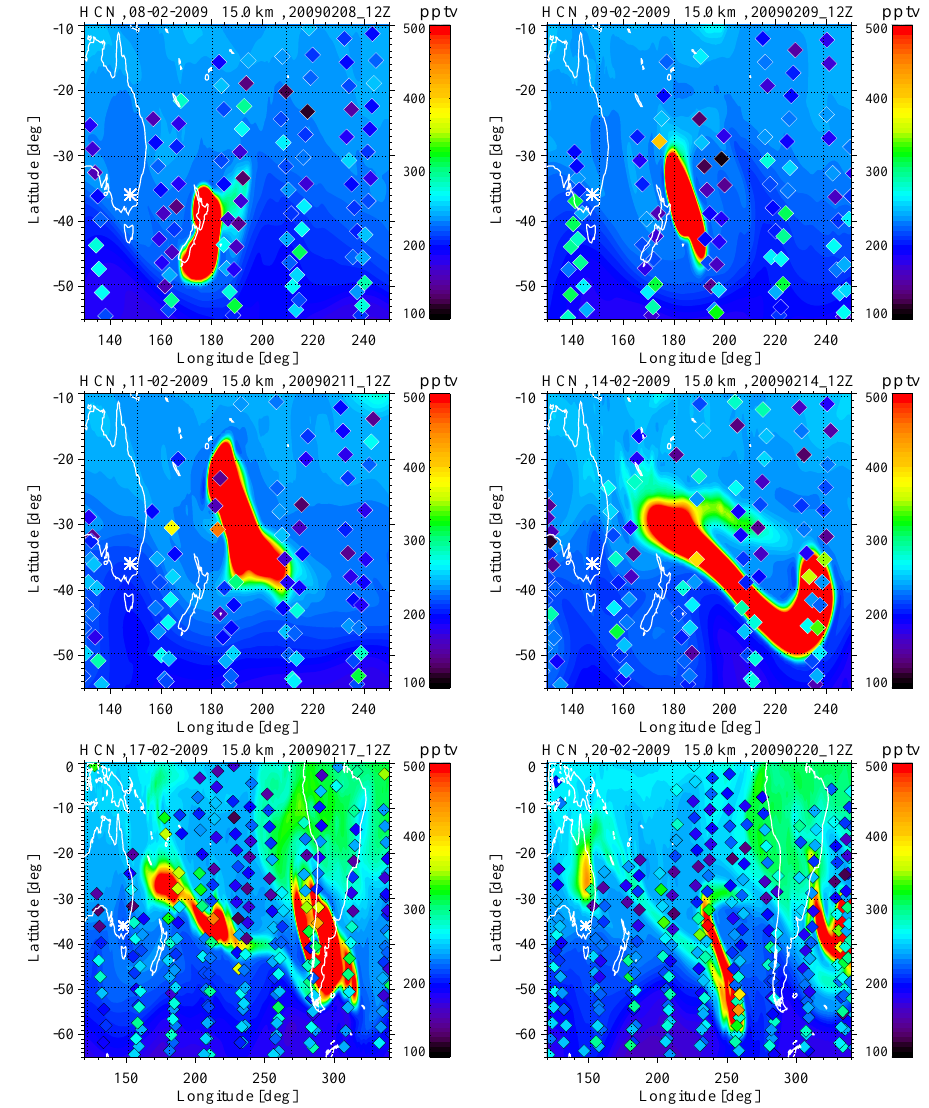
Fig. 4. Measured and modelled HCN at 15km altitude. Model distributions are smoothed vertically and along-track to MIPAS resolution. Note the different map section for the bottom panel. For more details see Fig.